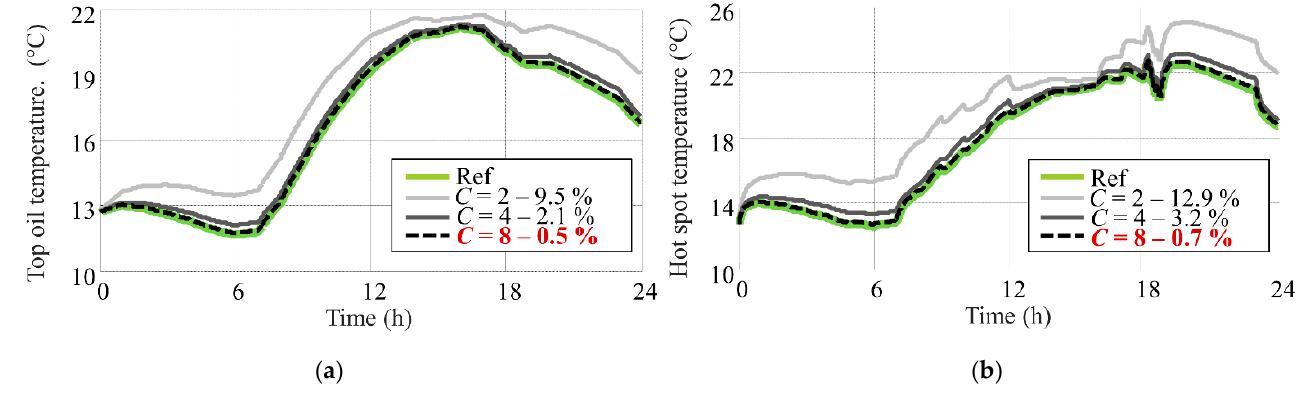
Figure 7. PWL performances for different numbers of blocks—( a ) top oil temperature; ( b ) hot spot temperature. The approximation error is computed through the normalized root-mean-square error (in %) for different numbers of PWL blocks. This error decreases significantly with more blocks considered. A value of C = 6 is ultimately chosen as it allows us to reach a deviation of less than 1% with the reference.